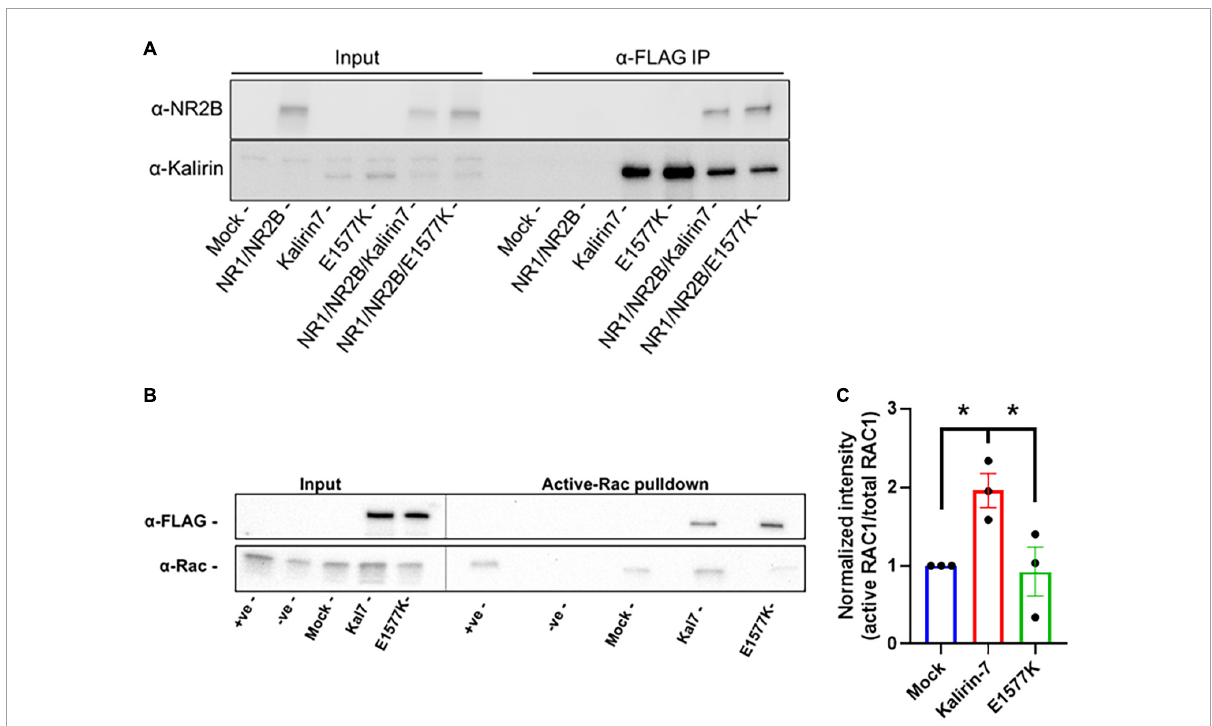
FIGURE6 E1577K shows impaired Rac1-GEF activity. (A) Western Blot of anti-FLAG pulldown of Kalirin-7 and E1577K from HEK293T, with co-immunoprecipitation of transfected NR2B (Mock = non-transfected). (B) HEK293T cells were transfected with the indicated conditions and active-Rac1 was pulled down from lysates with PAK-PBD coated Sepharose beads. Positive (+ ve) and Negative (-ve) samples indicate Mock transfected lysates Loaded with GTP- γ -S and GDP, respectively. Blots were probed with anti-FLAG and anti-Rac1. (C) Quantification of Active-RAC1 pulldown under the indicated conditions. * p <